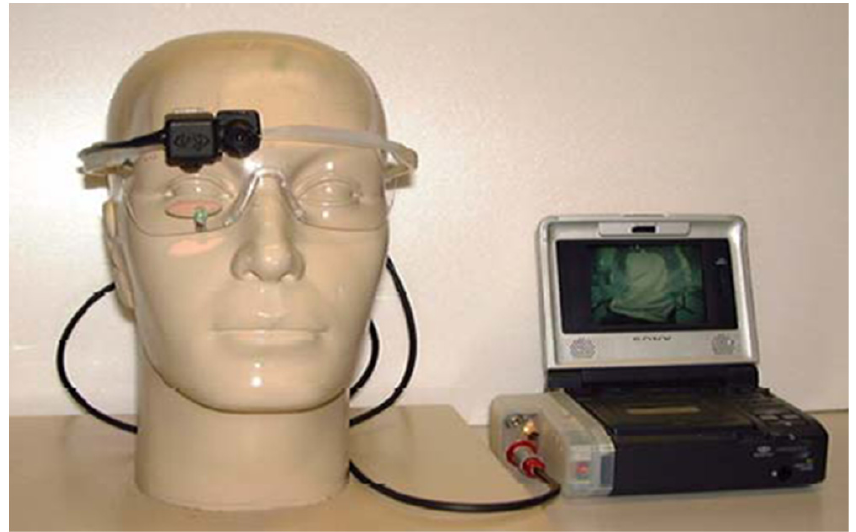
Figure 2. The used eye tracker.